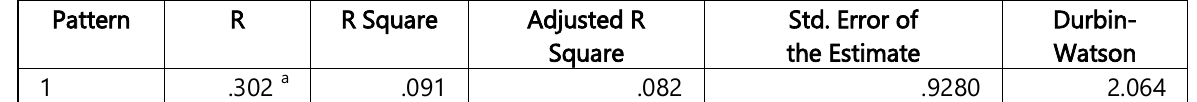
Table 12: Model Summary (Source: Authors’ calculation) Pattern R R Square Adjusted R Std. Error of Durbin- Square the Estimate Watson .302 a .091 .082 .9280 2.064